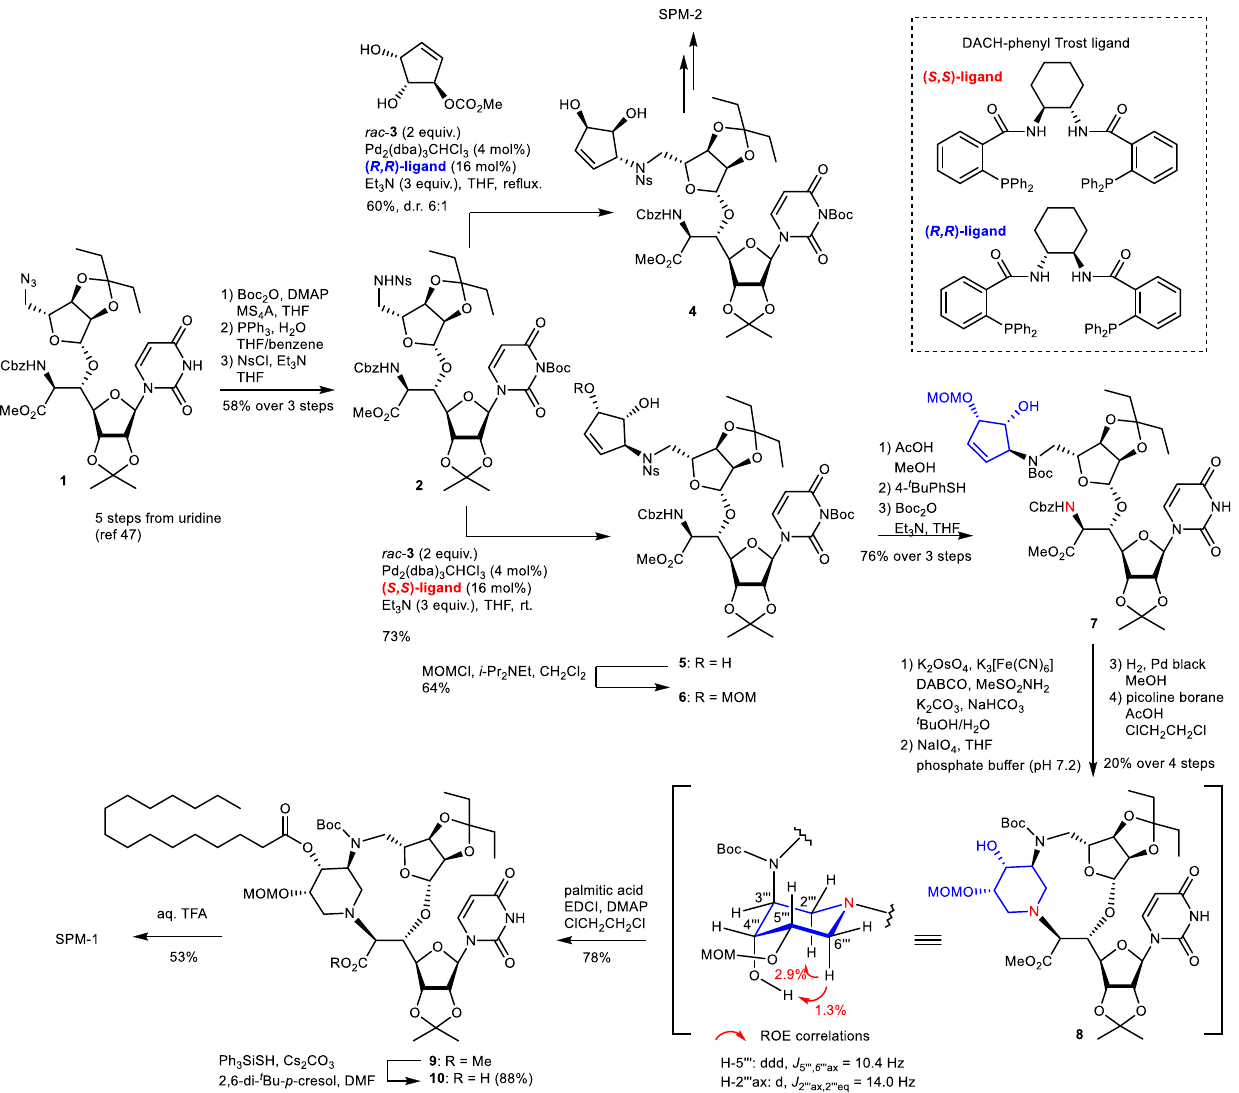
Fig. 4 | Synthesis ofSPM-1 and SPM-2. DABCO 1,4-diazabicyclo[2.2.2]octane, dba dibenzylideneacetone, EDCI 1-ethyl-3-(3-dimethylaminopropyl)carbodiimide, Ns nosy, ROE rotating frame nuclear Overhauser